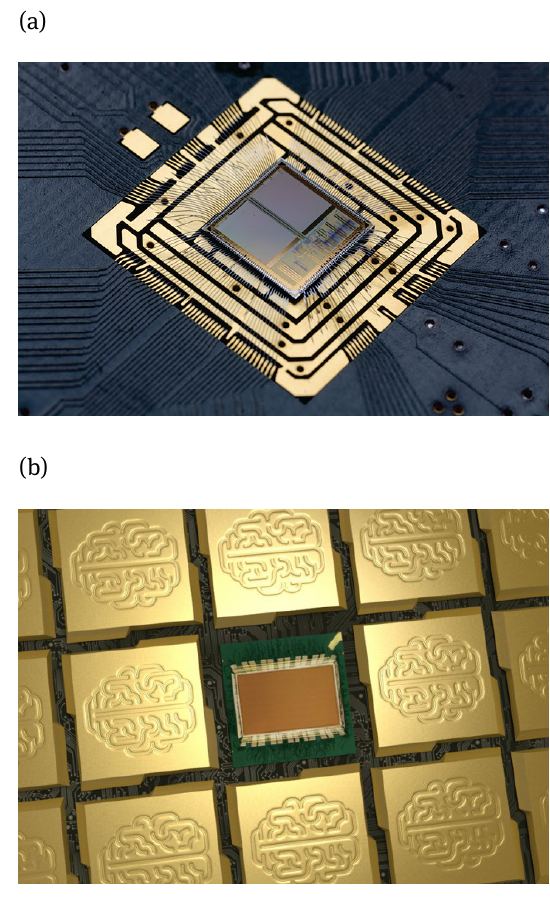
Figure 3: Neuromorphic Chips designed by Heidelberg group and IBM. (a) The Heidelberg Chip features 384 neurons, 100,000 Synapses and operates at a speed of approximately 100,000 times biological real time; (b) The new IBM chip, called TrueNorth, consists of 1 million programmable neurons and 256 million